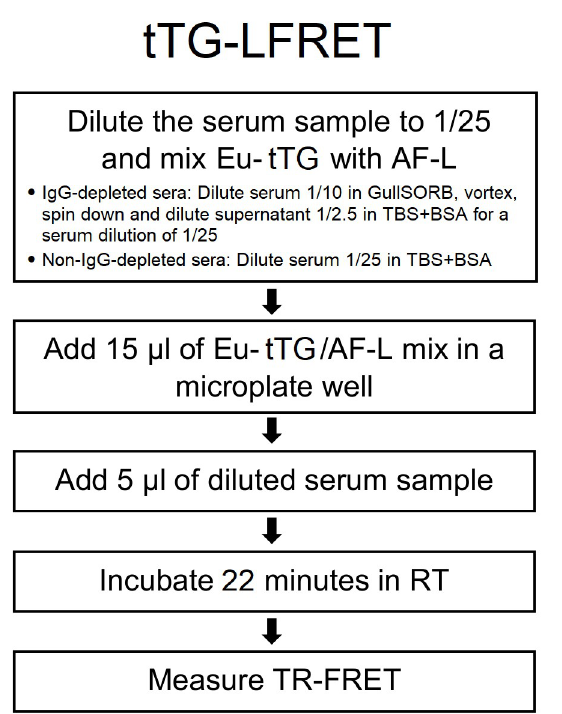
Fig 1. Simplified protocol for tissue transglutaminase protein L TR-FRET assay. Eu-tTG = Europium-labeled tissue transglutaminase, AF-L = Alexa Fluor ™ 647 -labeled protein L; TR-FRET = time-resolved Fo¨rster resonance energy transfer; RT = room temperature. We used TBS-BSA (50mM Tris-HCl, 150mM NaCl, pH 7.4, 0.2% BSA) for all component dilutions. On-plate serum dilution was 1/100 and reagent concentrations were 250 nM for AF-L and 5 nM for Eu-tTG. For further details, see the previous publication